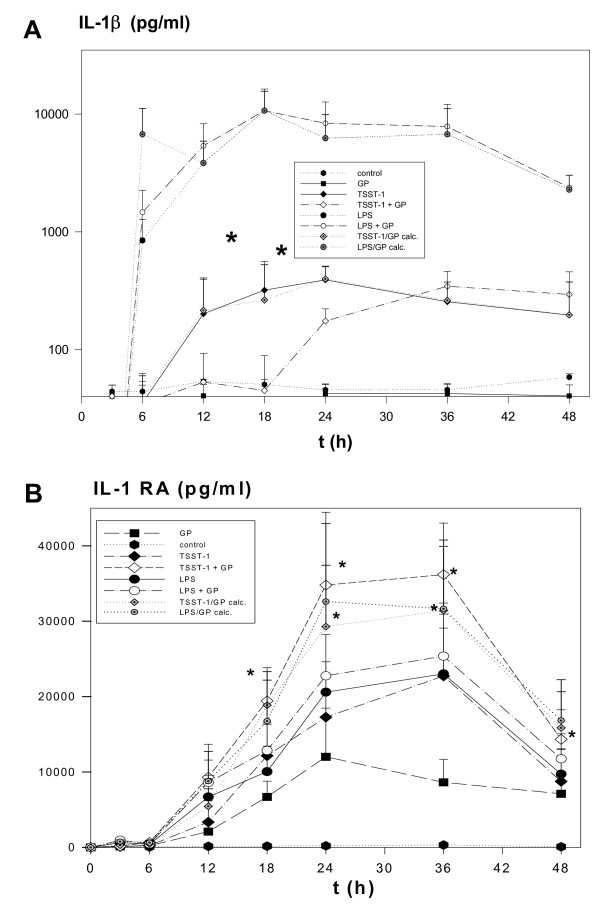
A, IL-1β was down-regulated (12 h – 24 h) following GP + TSST-1 when compared to TSST-1. Time course (48 h) of IL-1β production (pg/ml) by human PBMC incubated with medium control, 100 μg GP, 250 ng TSST-1, GP + TSST-1, 250 ng LPS and GP + LPS. At 18 h and 24 h there was a marked reduction in IL-1β production following GP + TSST-1 when compared to TSST-1 (* = p < 0.05). Graphs depicting the theoretical values for GP/LPS calc. and GP/TSST-1 calc. are also shown. IL-1β levels in the supernatnant were obtained by Elisa and are shown as mean ± SEM (n = 3). B, IL-1RA was exaggerated following GP + TSST-1 (12 h – 48 h) when compared to TSST-1. Time course (48 h) of IL-1RA production (pg/ml) by human PBMC incubated with medium control, 100 μg GP, 250 ng TSST-1, GP + TSST-1, 250 ng LPS and GP + LPS. Between 18 h and 48 h a simultaneous treatment of PBMC with GP + TSST-1 led to a synergistic effect, i.e. a higher IL-1RA production when compared to an addition of the single values for TSST-1 and GP (* = p < 0.05). Graphs depicting the theoretical values for GP/LPS calc. and GP/TSST-1 calc. are included. IL-1RA levels in the supernatnant were obtained by Elisa and are shown as mean ± SEM (n = 3).